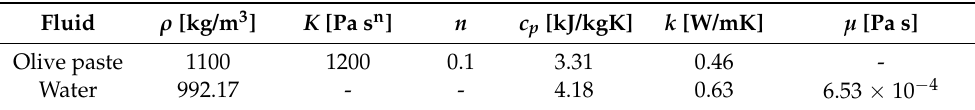
Table 2. Thermo-physical and rheological parameter of the olive paste and water. Fluid ρ [kg/m 3 ] K [Pa s n ] n c p [kJ/kgK] k [W/mK] µ [Pa s] Olive paste 1100 1200 0.1 3.31 0.46 - Water 992.17 - - 4.18 0.63 6.53 × 10 −